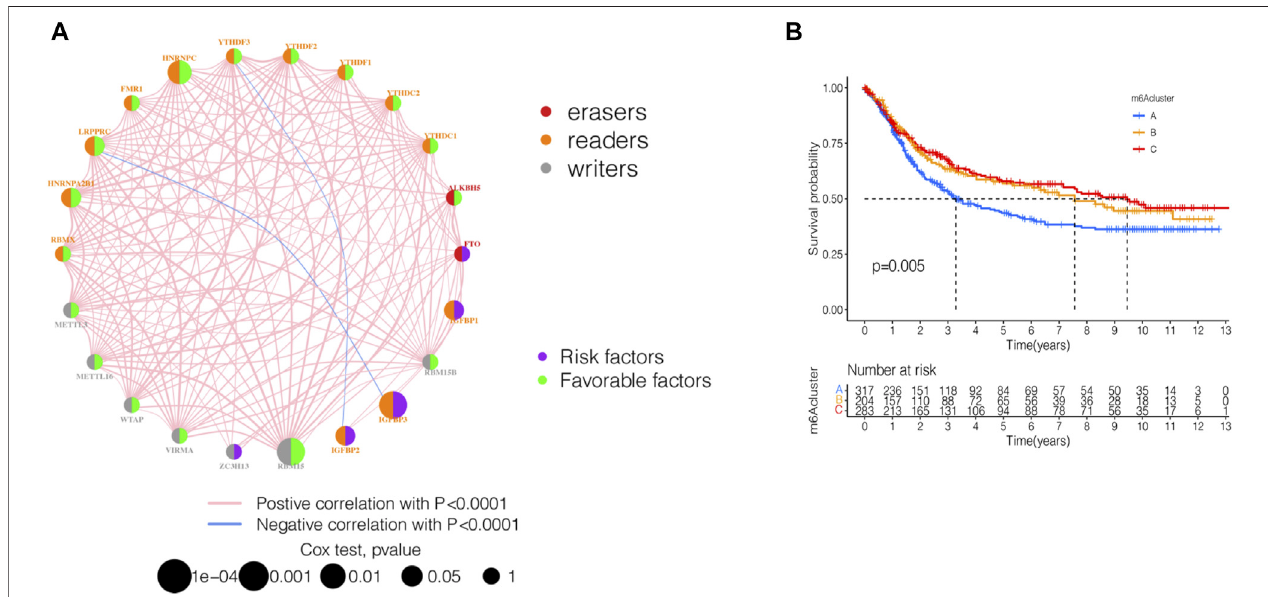
FIGURE 2 | Identi fi cation of m6A methylation modi fi cation patterns in STAD. (A) Interaction of 23 m6A regulators and their prognostic signi fi cance in STAD. The circle size represented the effect of each regulator on the prognosis, and the range of values calculated by Cox test was p < 0.001, p < 0.01, p < 0.05, and p < 1, respectively. (B) Kaplan – Meier curves of m6A modi fi cation patterns. Kaplan-Meier curves with Log-rank p -value 0.005 showed a signi fi cant survival difference among three m6A modi fi cation patterns.